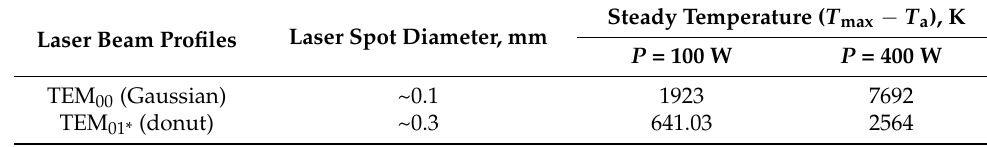
Table 4. The steady temperature values at the laser spot boundary for two laser modes.